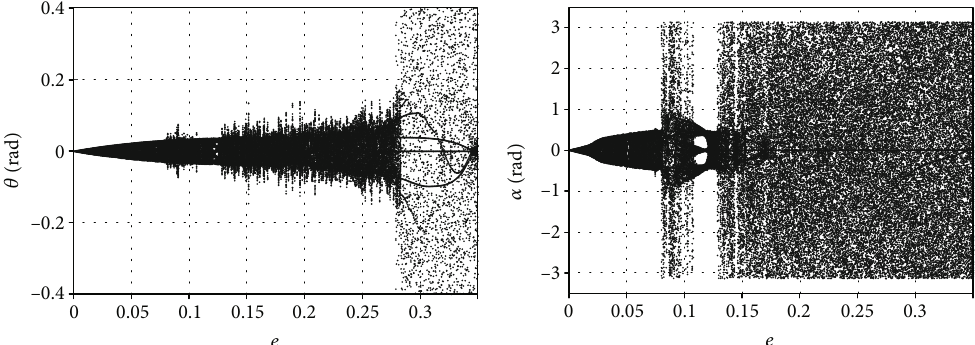
Figure 4: Bifurcation diagrams changing with orbital eccentricity e under combination resonance.